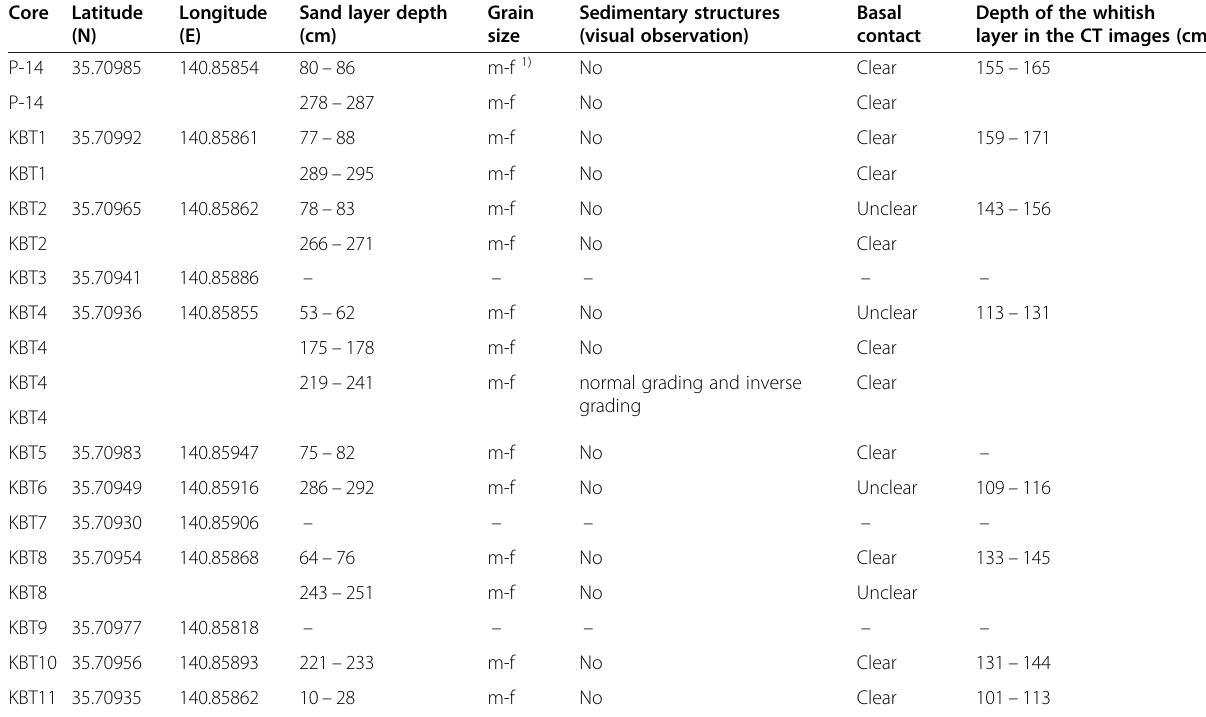
Table 1 Sampling cores and sedimentary characteristics of each sand layer Core Latitude (N)